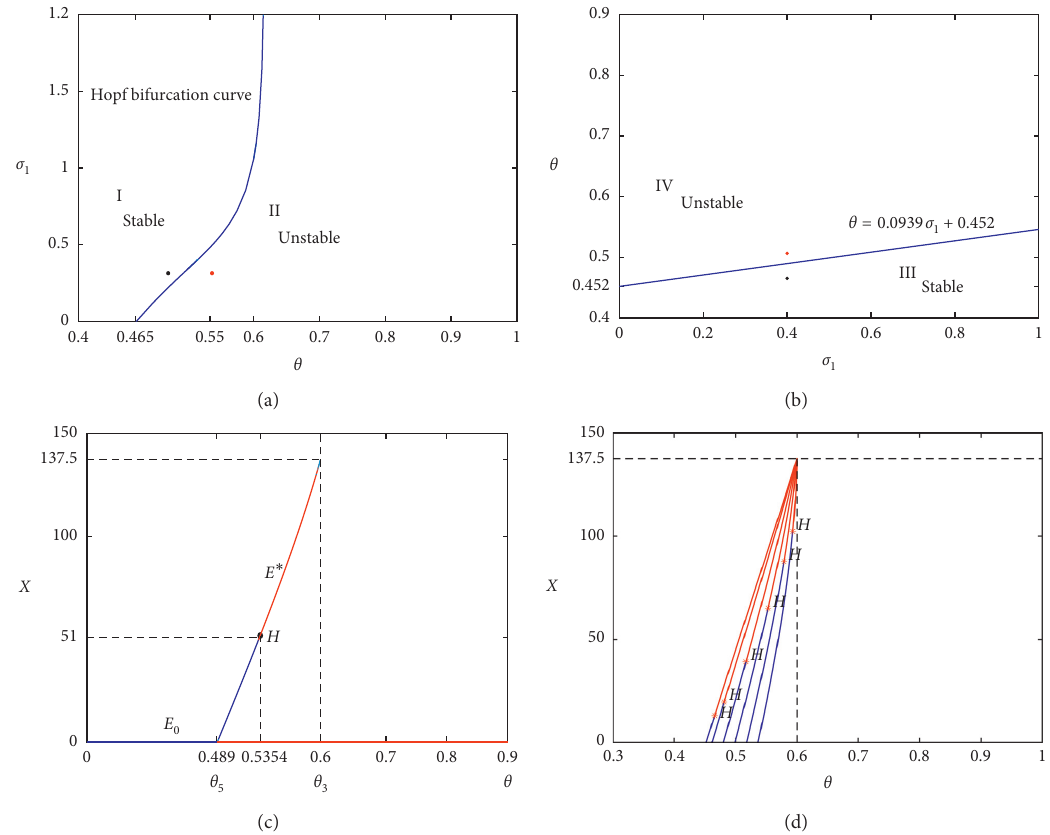
Figure 5: (a) Stability region of E ∗ and Hopf bifurcation curve in θ − σ is stable in region III and unstable in region IV . (c) The bifurcation diagram of x with respect to θ for fixed σ (b) ACI curve. E 0 bifurcation point appears at θ ∗ ACI � 0 . 5354. (d) The bifurcation diagram of x with respect to θ for different σ blue curves represent the stable steady states of system (34), while the red curves represent the unstable steady